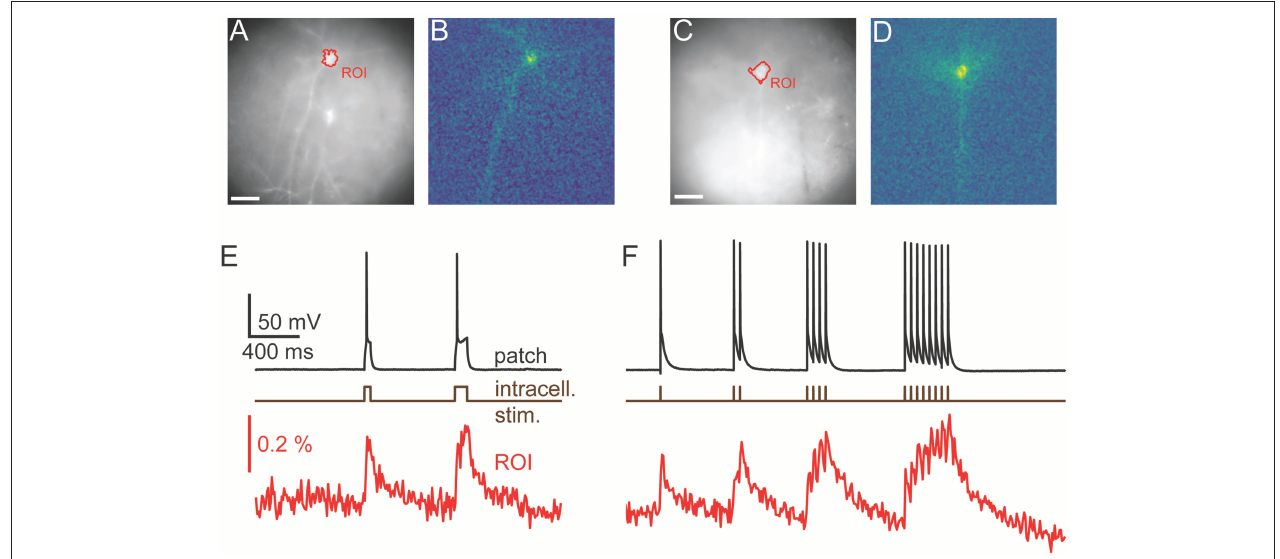
FIGURE 3 | Imaging reveals dendritic structure. Wide-field (A,C) and activity maps (B,D) of two cortical pyramidal cells. Activity maps were generated by calculating the integral over stimulated video frames and pick out an individual cells dendritic structure, including basal and apical dendrites, from adjacent cells. (E,F) the average time courses from the videos used to calculate the activity maps. Optical traces are averages of 12 (E) and 10 (F) repeats, scale bars 40 µ m. Fluorescence traces shown on inverted y axes.